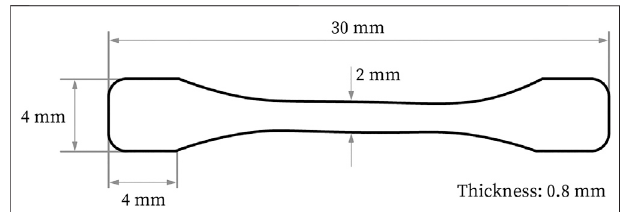
FIGURE 2 | Dimensions of the PPS-40%gf and PSU dogbone samples. Gauge length 13